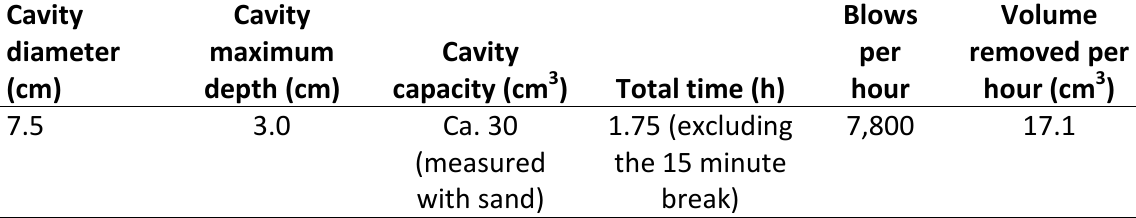
Table 1. Results of our experiment for the replication of a basalt mortar.